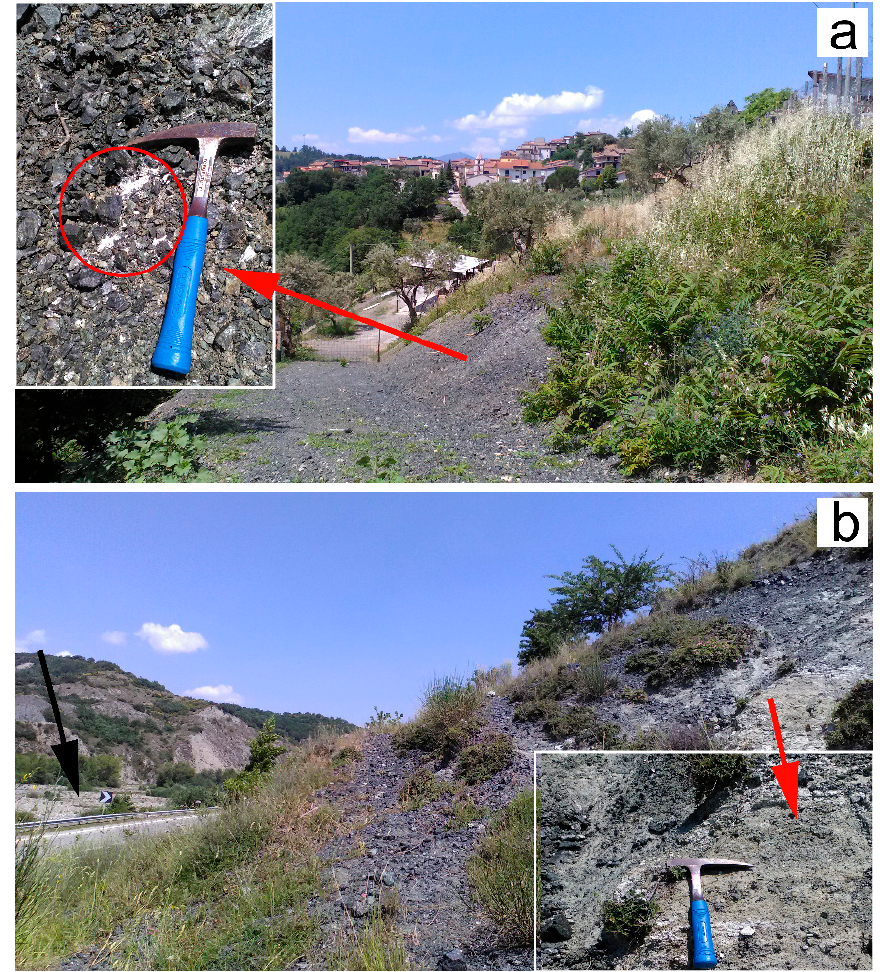
Figure 2. ( a ) Distant view of the Episcopia village, with appearance of serpentinite at the road cut near to the village (the red circle encloses white fibers of asbestos tremolite); and ( b ) pictures show vivid green serpentine at the road cut near to the village of Episcopia (highway 656 indicated by the black arrow). Inserts depict a zoomed-in area.